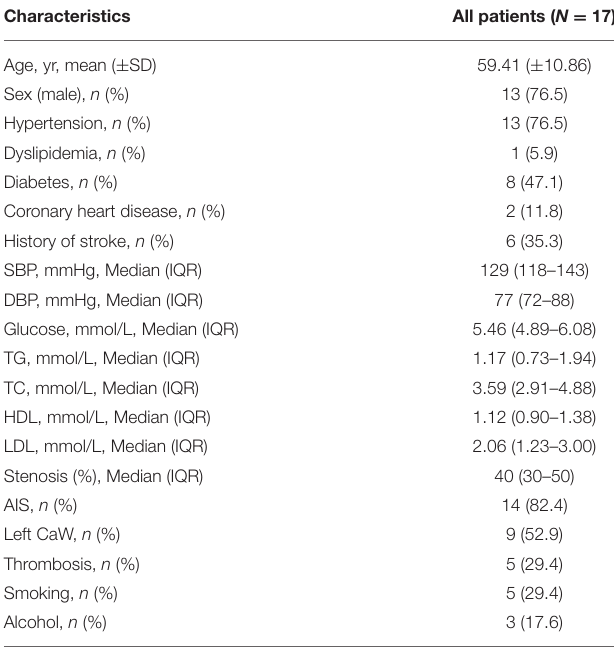
TABLE 1 | Clinical characteristics of CaW